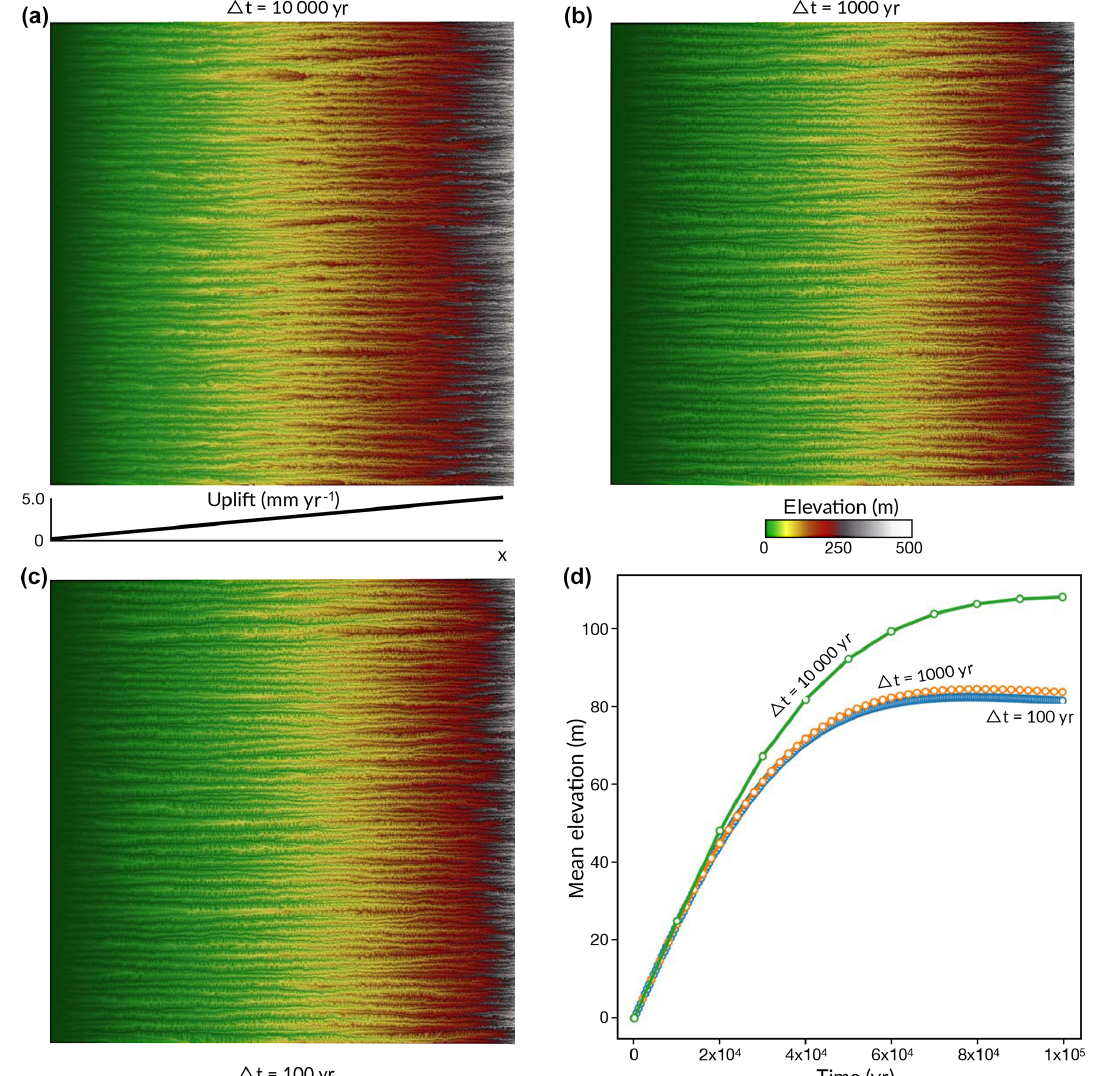
Figure 3. Resulting topographies of an initial flat squared surface (100km side) after 100000 years of uniform precipitation and linear uplift from west to east. Three simulations are performed in which the time step (cid:49)t is set to (a) 10 4 , (b) 10 3 , and (c) 10 2 years. Panel (d) presents the temporal change in mean elevation for the three cases. Differences between the runs are related to the transient nature of landscape